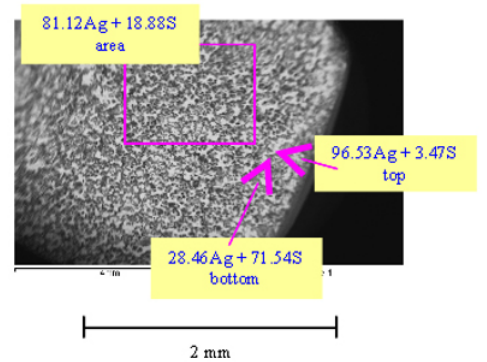
Figure 4. SEM micrograph fragment of magnesium disk surface with area and microlocal (top and botton) content of silver and sulfur after 3 min cementation in 0.005 M [Ag(S solutions at 20 o C